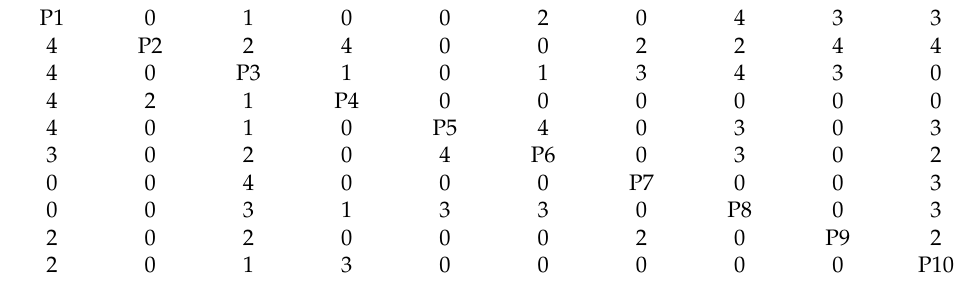
Table 4. RES interaction